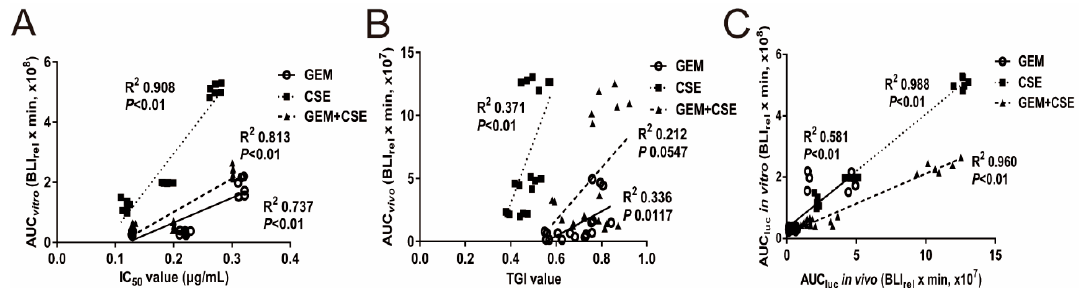
Figure 5. The intracellular bioluminescent pharmacokinetic parameter AUC shows a strong association with anti-tumor e ffi cacy in vitro and in vivo. ( A ) BxPC3 luc cells were exposed to GEM, CSE or GEM and CSE combination for 24, 48 and 72 hours. The correlation coe ffi cient R 2 and p value between the bioluminescent pharmacokinetic parameter AUC luc and the anti-proliferation parameter IC50 for each drug at each treatment time point were determined by Pearson correlation model. ( B ) The xenograft mice bearing BxPC3luc cells were intravenously injected with GEM, CSE or GEM and CSE combination. The bioluminescent pharmacokinetic parameter AUCluc and the anti-proliferation parameter TGI were measured on days 7, 14 and 25. The correlation coe ffi cient R2 and p value between AUCluc and TGI for each drug and treatment time point were determined by Pearson correlation model. ( C ) The association between in vitro AUCluc and in vivo AUCluc for GEM, CSE or GEM and CSE combination at each measurement time point were compared. The correlation coe ffi cient R2 and p value were determined by Pearson correlation model. Table 3. The in-vitro and in-vivo association of bioluminescent pharmacokinetic parameters. Group